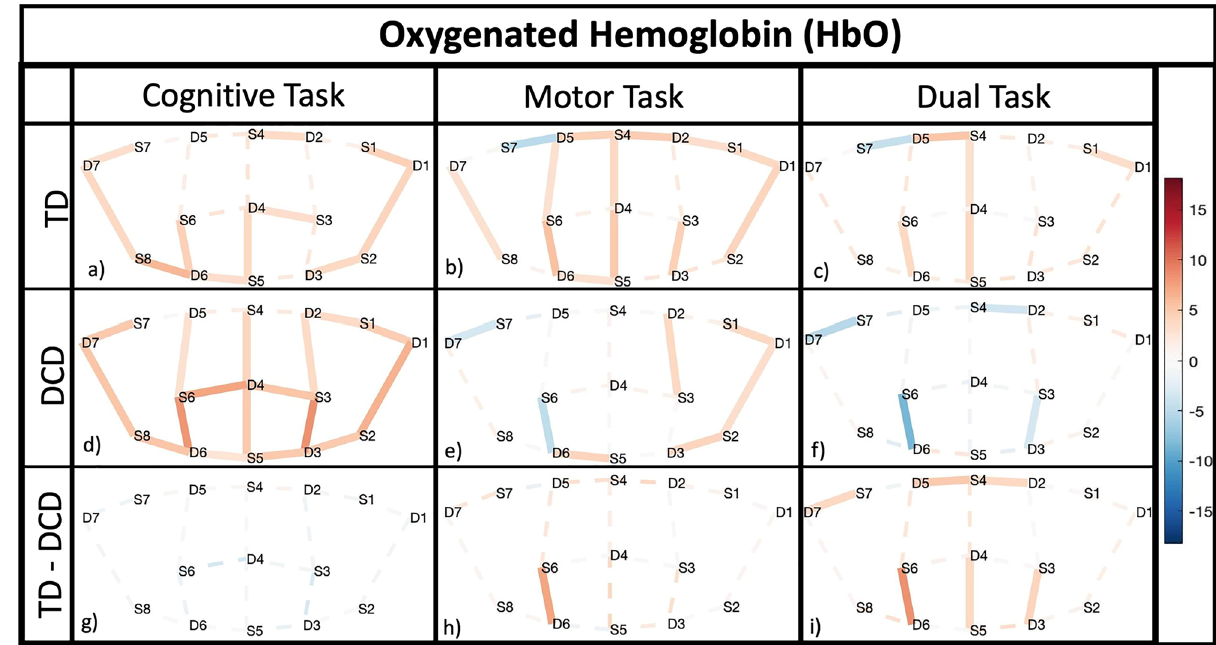
Figure 2. Neuroimaging and Neurobehavioral results for 85 subjects, displaying areas of interest across the PFC comparing differences between groups (TD of DCD) and task (Cognitive, Motor, or Dual Task). fNIRS results are displayed per group (rows 1&2) and task (columns 1–3), and between group (row 3). Red bars indicated increased HbO (activity), while blue bars represent decreased HbO according to international 10–10 system. Each group and task are assigned a specific legend (a through i) for reference within the